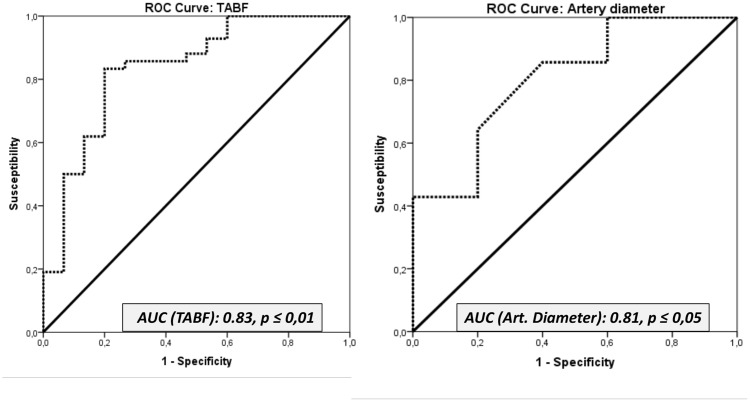
Receiver operating characteristic (ROC) curves for the parameters TABF and the diameter of the capsular artery.AUC: Area under the Curve.